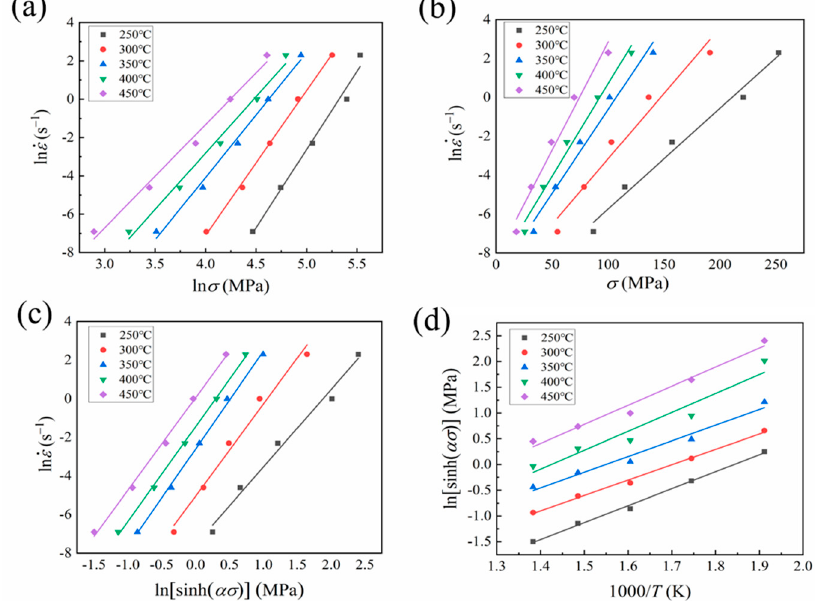
. . . . . . ε versus ln σ p , ( b ) ln ε versus σ p , ( c ) ln ε versus ln[sinh( ασ p )] and ( d ) ε versus σ ε versus ln σ ε versus ln[sinh( ασ p , ( b ) ln p , ( c ) ln